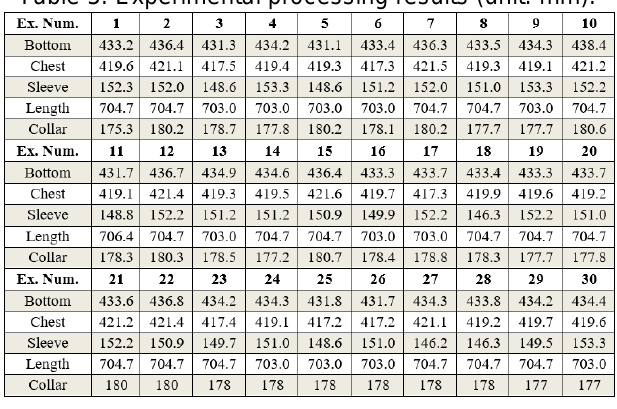
Table 3. Experimental processing results (unit: mm).